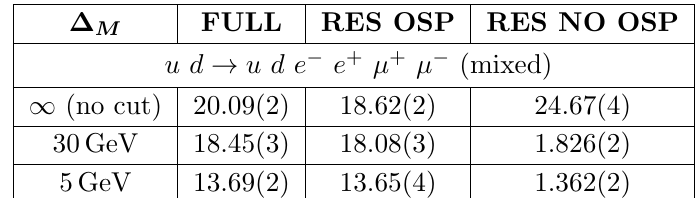
Table 7 . Cross sections ( ab ) for u d All diagrams are taken into account for the full calculation (FULL), while only double resonant diagrams contribute to the two rightmost columns, with (RES OSP) and without (RES NO OSP) projection. Selection cuts are: p j 300 GeV, M > 40 GeV. ‘ + ‘ (cid:0)